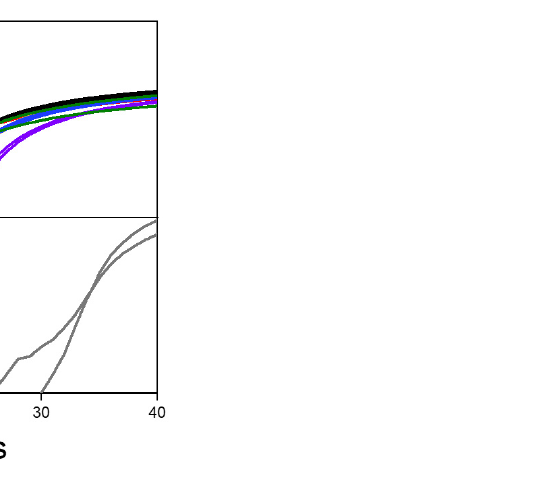
Table 3. The number of PIN particles against matrix concentration.